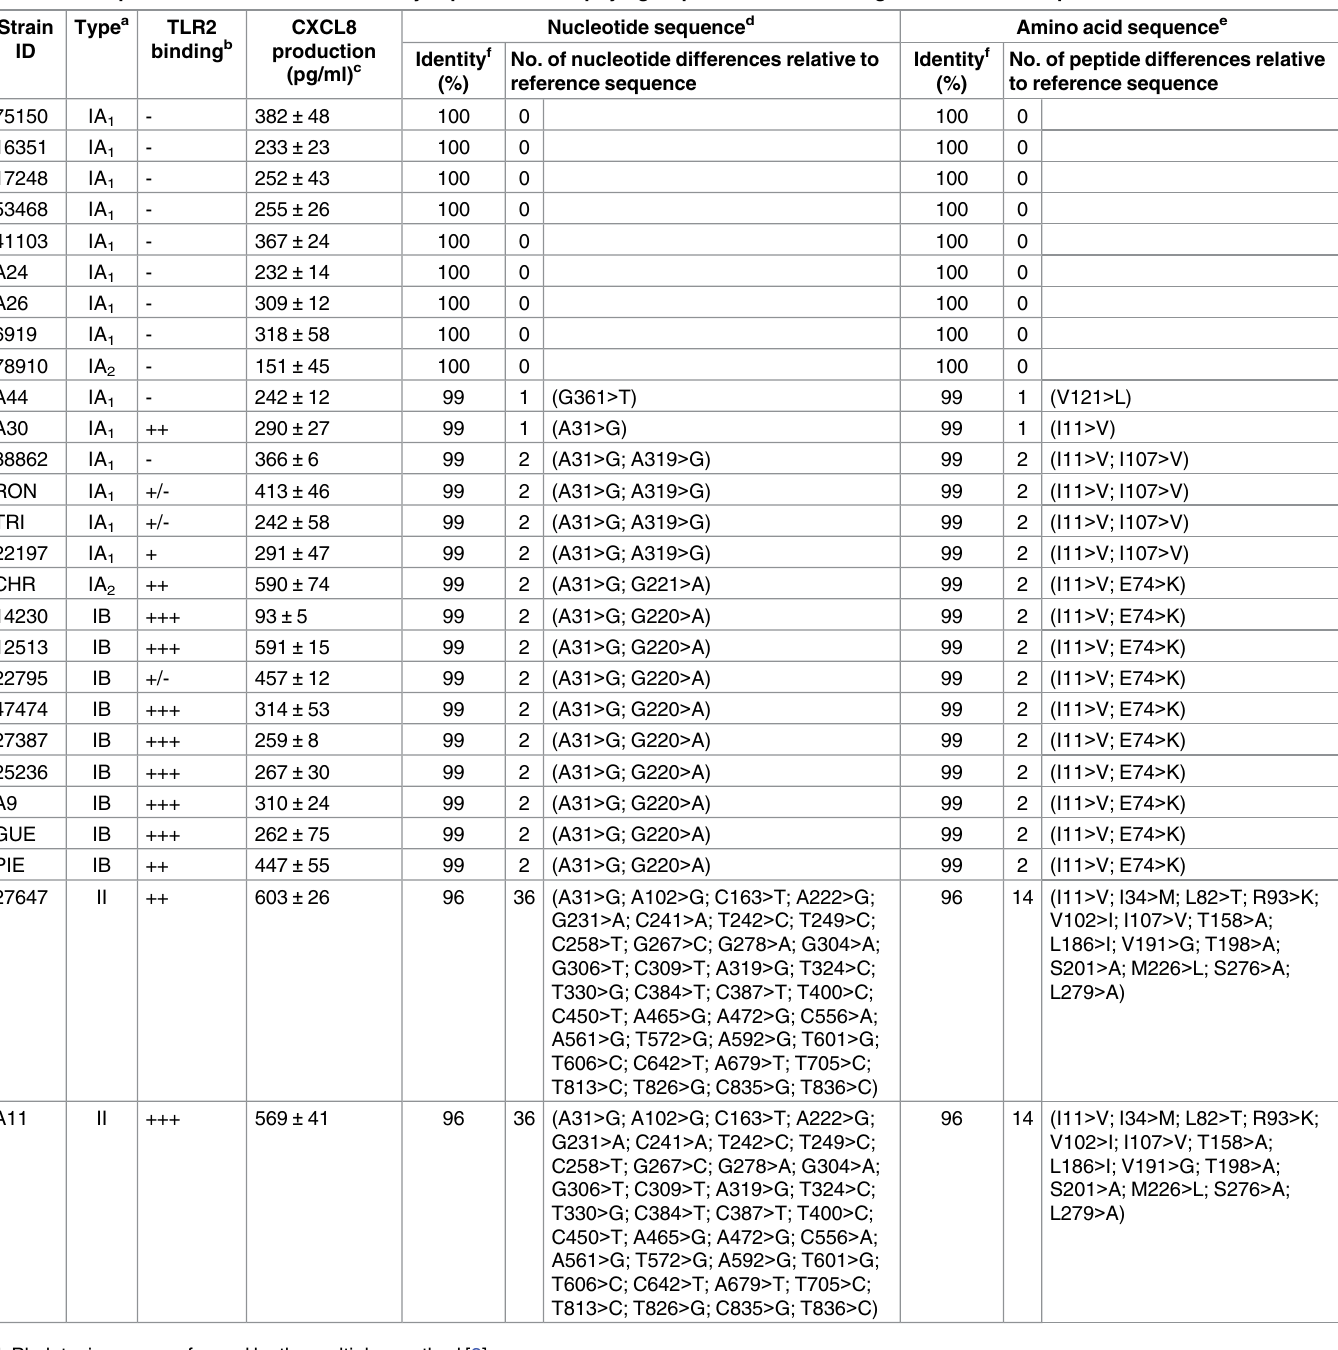
Table 2. Comparison of P . acnes inflammatory capabilities with phylogroup and CAMP factor 1 gene nucleotide sequence Strain